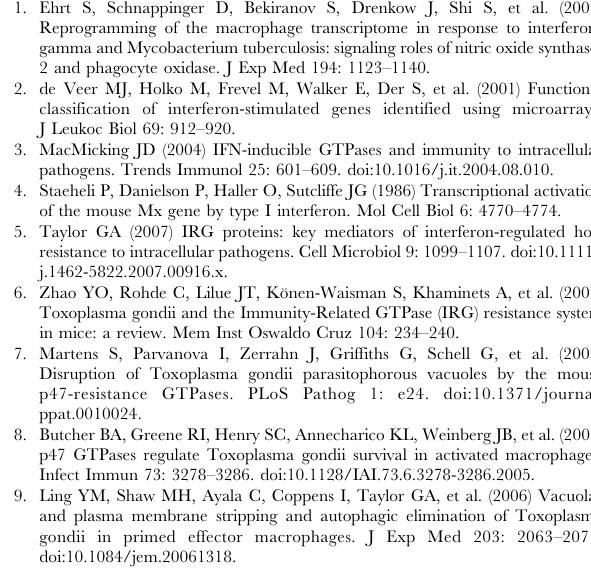
Figure S6 Farnesylation of mGBP2 and mGBP5 is dispensable for targeting to type II T. gondii vacuoles. Confocal pictures show MEFs that overexpress either HA- mGBP2(C586S) or HA-mGBP5(C587S) infected with type II T. gondii (Pru). MEFs that overexpress HA-mGBP2(C586S) or HA- mGBP5(C587S) were stimulated with 200 U/ml IFN- c overnight and infected with type II T. gondii for 1 h. Cells were stained with a rat monoclonal anti-HA antibody (Roche Applied Science). mGBP2 and mGBP5 were able to localize to PVs without any modification by prenyltransferases. Table S1 Primer sequences. Primer sequences for cloning primers and quikchange primers are listed. In addition to the sequences, the corresponding restriction enzymes used for digestion, the introduced mutations, the binding sites or the product lengths are